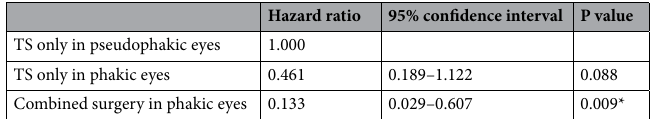
Table 3. Comparisons between the surgical procesures for achieving IOP < 15 mmHg and ≥ 20% reduction with no additional treatments. Cox proportional hazards model adjusted for age, sex, best-corrected visual acuity, intraocular pressure, and eye drop score at baseline. *P < 0.05.